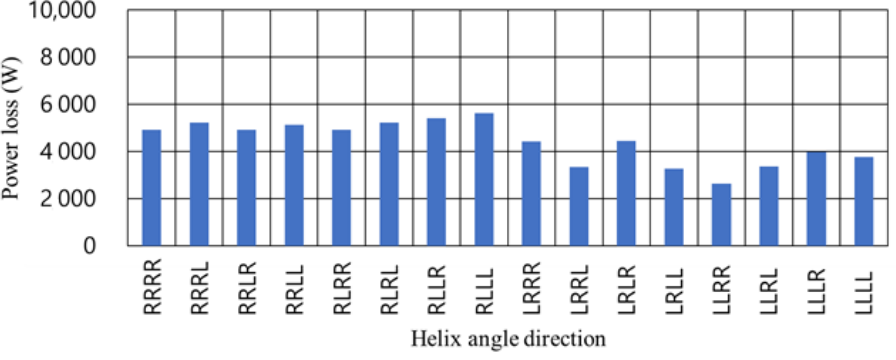
Figure 10. Total bearing power losses of the entire combinations of helix angle directions.